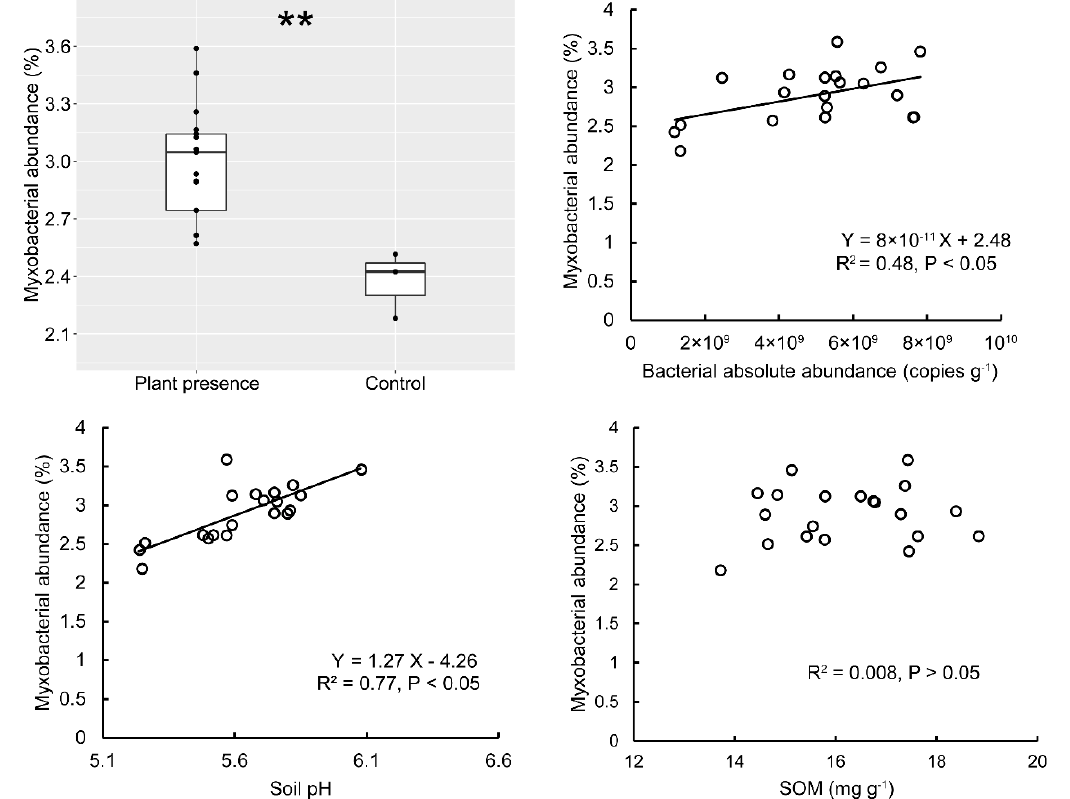
Figure 4. The relative abundance of soil myxobacteria and the correlation with soil bacteria abundance, soil pH and SOM content from the greenhouse mesocosms experiment. The asterisk (**) indicates significant difference between plant presence and the no-plant control. Linear functions, coefficients and p values are used to describe the significant correlations.